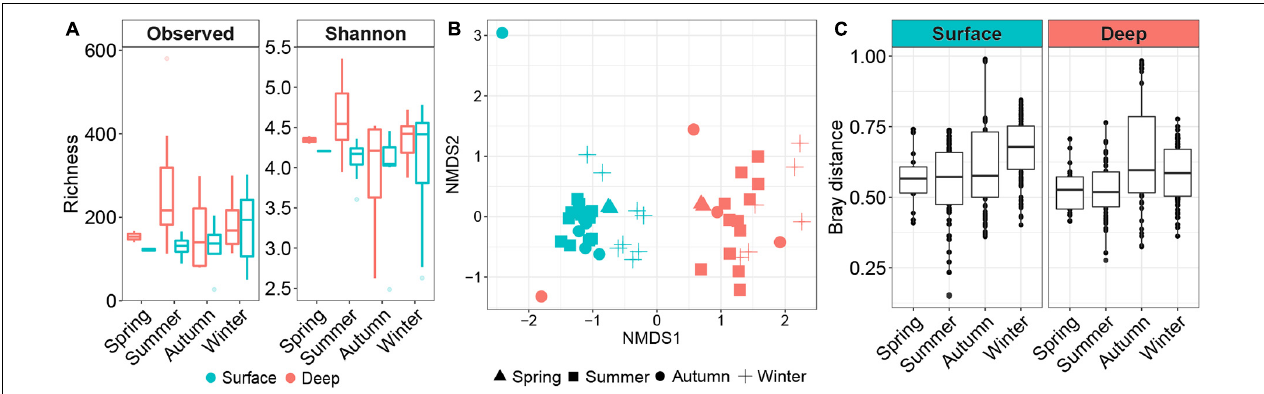
FIGURE 2 | Seasonal variation in surface (blue) and deep (500 m) (red) water prokaryotic community (A) alpha diversity, both observed and Shannon index, (B) beta diversity visualised with non-metric multidimensional scaling (NMDS) based on Bray-Curtis dissimilarities with seasons depicted with different shapes (stress = 0.108), and (C) comparison of prokaryotic community composition seasonal dissimilarity where all samples are compared to summer for surface and deep separately. Samples were collected from the Munida Microbial Observatory Time-Series (MOTS) over a 3-year period and grouped into meteorological seasons.